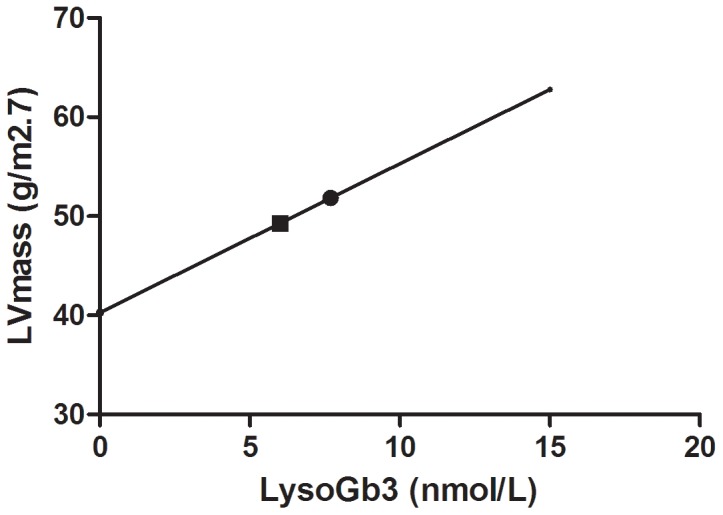
LVMass reduction and LysoGb3.LVMass decreases as lysoGb3 decreases. The dot represents the mean lysoGb3 and mean LVmass in females at start of ERT treatment, the square depicts mean lysoGb3 one year after start of ERT.